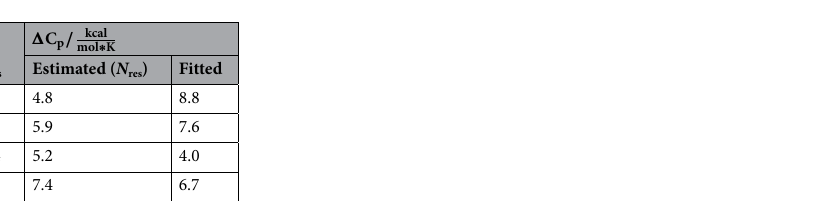
Figure 2. K d fits for simulated data with ∆ C p = 8 kcal/mol K and 2% noise. K d deviations coded with green corresponding to the initial value. Datesets outside the range are shown as white circles. Fitting the ∆ C p during the thermal curve fitting process results in better agreement with the initial K d values ( B ) compared to fits with a fixed ∆ C p = 0 kcal/mol K ( A ). The fitted ∆ C p values are shown in Supplementary Information S22–S23.